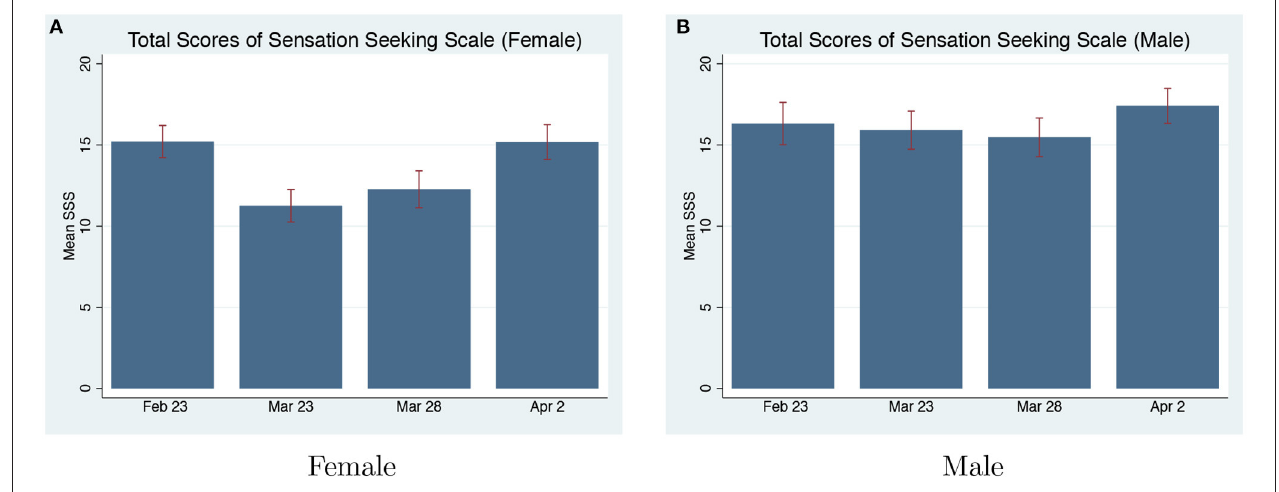
FIGURE 6 | SSS-total scores pre and on-pandemic. (A) Total scores of sensation seeking scale (Female). (B) Total scores of sensation seeking scale (Male).